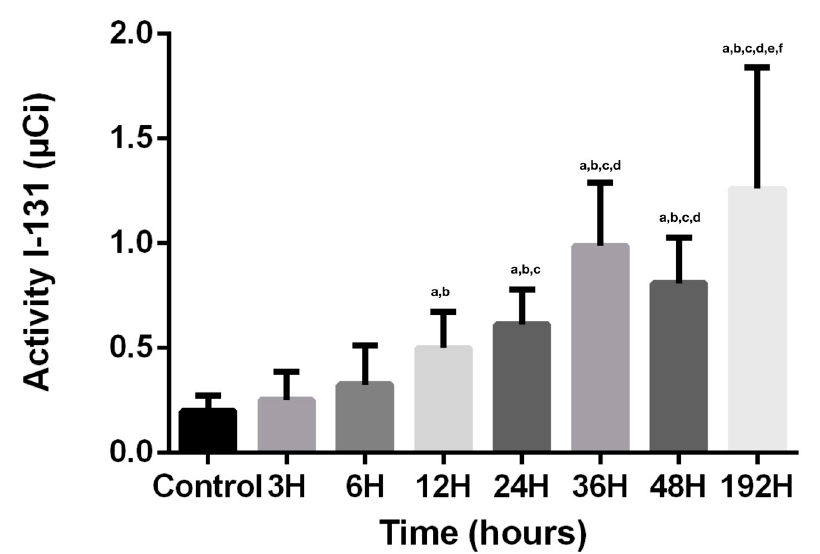
Figure 1. Activity of radioiodine. Values are expressed in mean ± SD. a p < 0.05 compared to CTR group; b p < 0.05 compared to IRD3 group; c p < 0.05 compared to IRD6 group; d p < 0.05 compared to IRD12 group; e p < 0.05 compared to IRD24 group; f p < 0.05 compared to IRD48 group.